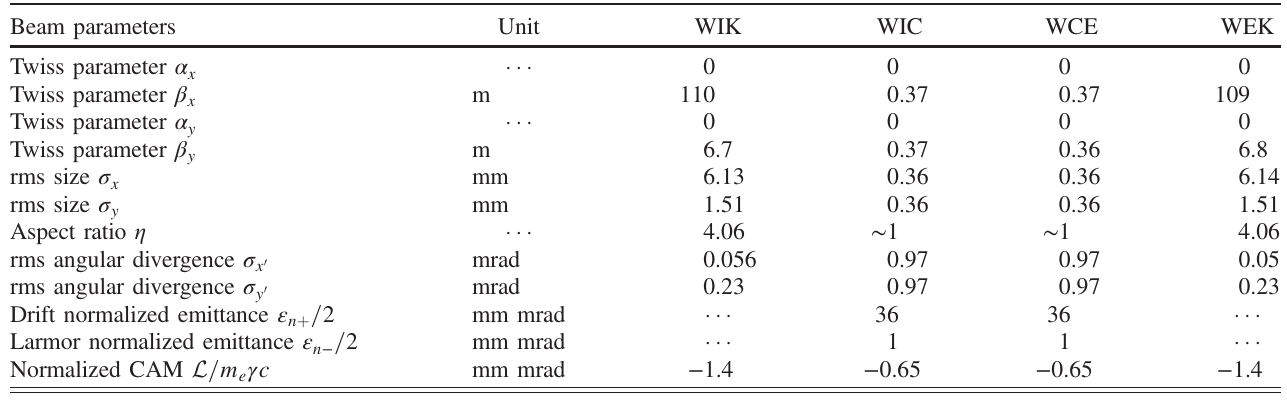
TABLE IV. The averaged beam parameters of the magnetized beam along the CCR over 11 passes. WIK is injection kicker entrance, WIC is the cooler entrance, WCE is cooler exit, and WEK EK exit. There is a mirror symmetry in the beam parameters with respect to the